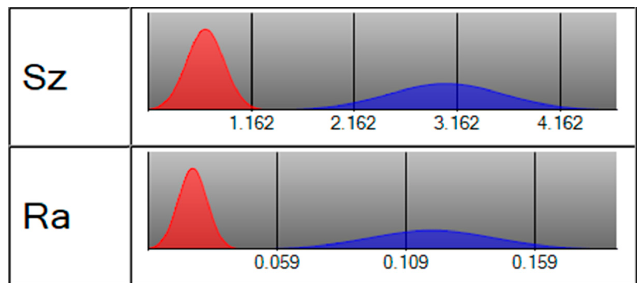
Figure 10. Surface morphology under different vibration amplitudes.